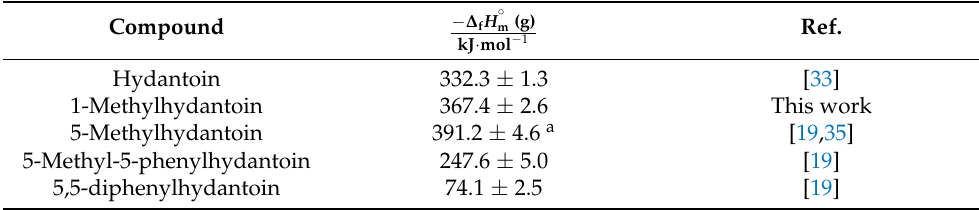
Table 8. Enthalpies of formation, in gaseous phase, at T = 298.15 K of hydantoin and some of its derivatives.